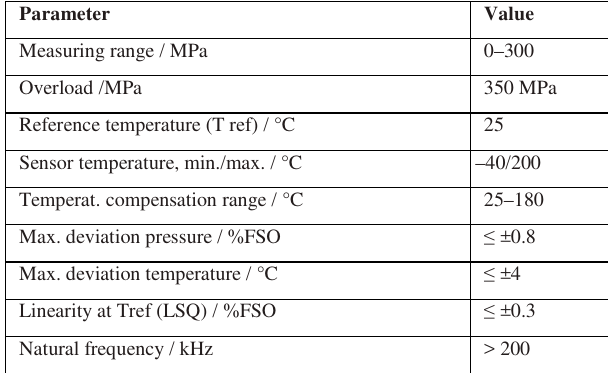
Table 2. Kistler type 4067E pressure transducer specifications according to [28]